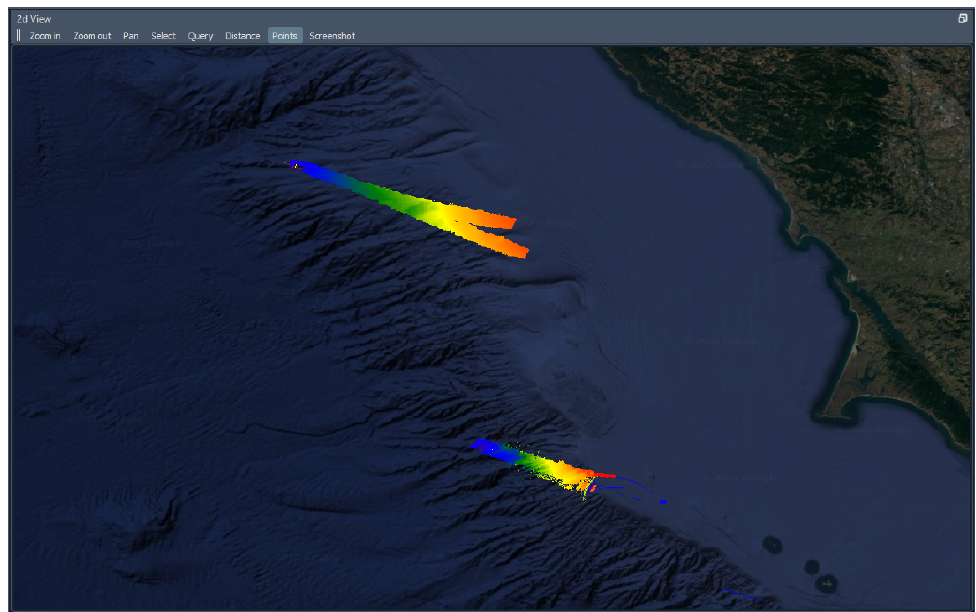
Figure 9. Extinction test area and gridded datasets with 64 m resolution shown on top of the Satellite WMS